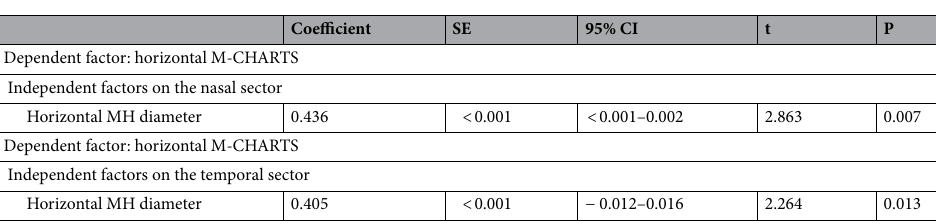
Table 4. Multivariate regression analysis for M-CHARTS score at baseline. Independent factors: age, sex, INL%, OR%, RD%, MH diameter. The INL%, OR% and RD% for the nasal, temporal, superior and inferior sectors were selected respectively. Horizontal MH diameter was selected for the nasal and temporal sectors and vertical MH diameter was selected for the superior and inferior sectors. INL% and OR% were defined as the rates of change before and after surgery in INL and OR thicknesses measured in four sections of the macula: nasal, temporal, superior, and inferior, at 1000 μm away from the center of the fovea. SE standard error, CI confidence Interval, MH macular hole, INL % the rate of change in inner nuclear layer thickness, OR % the rate of change in outer retinal layer thickness, RD % the rate of change in retinal distance.